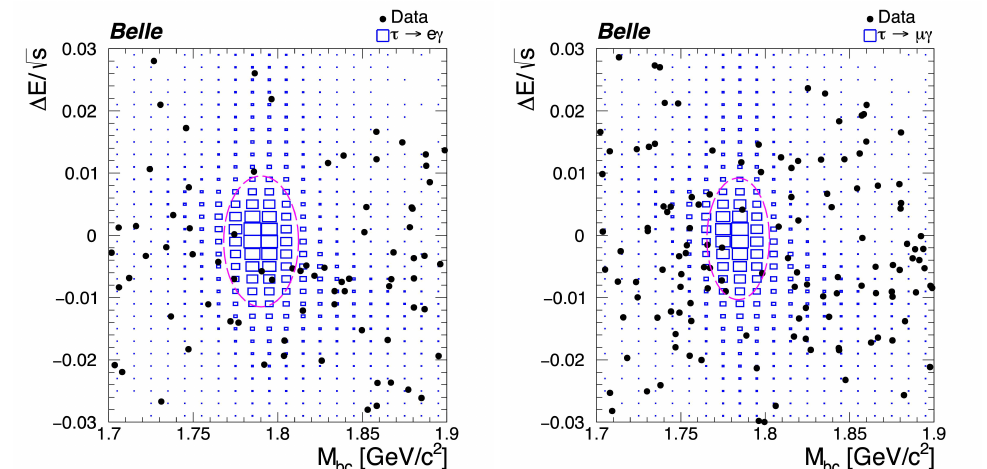
√ Figure 3. Two-dimensional distributions of ∆ E / s versus M bc for Belle searches [70] for τ − → e − γ ( left ) and τ − → µ − γ ( right ) decays. Black points are data, blue squares are τ − → (cid:96) − γ signal MC events, and magenta ellipses show the signal region ( ± 2 σ region). This figure has been reprinted with permission from Ref. [70].